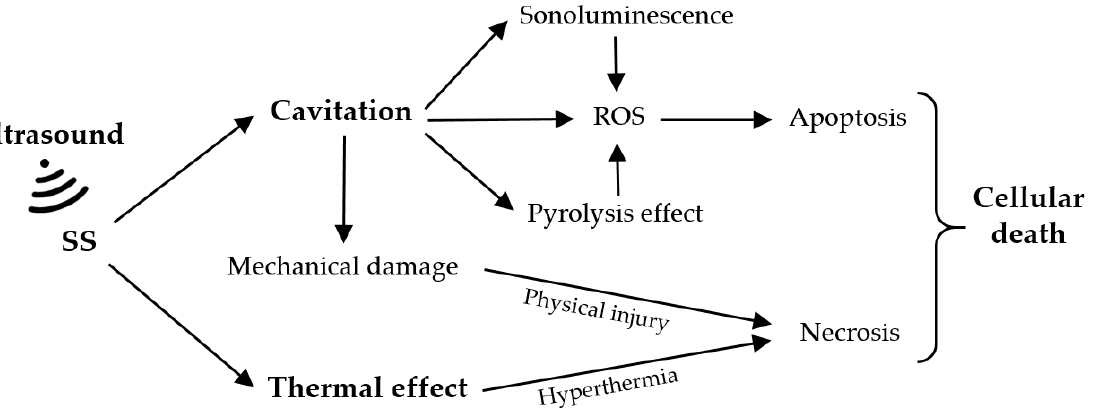
Figure 6. Possible SDT-mediated action mechanisms. Adapted from [87].